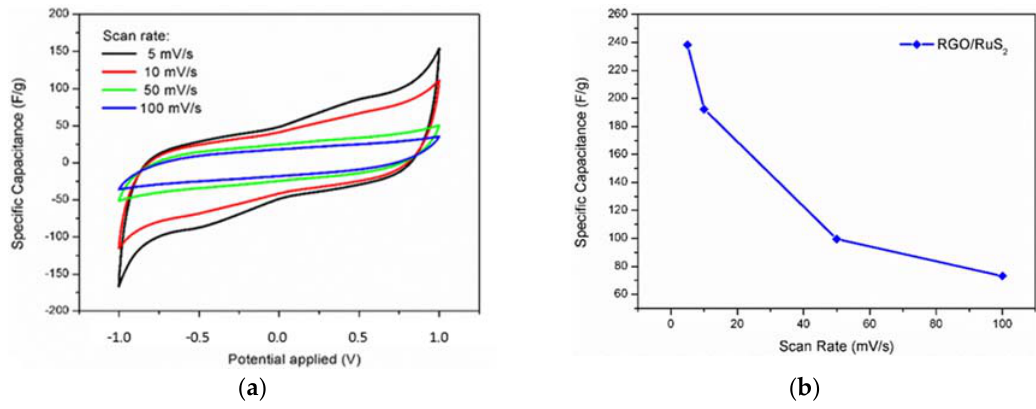
Figure 4. ( a ) cyclic Voltammograms of RGO/Ruthenium active species hybrid at different scan rate; ( b ) evolution of the Specific Capacitance with the scan rate.